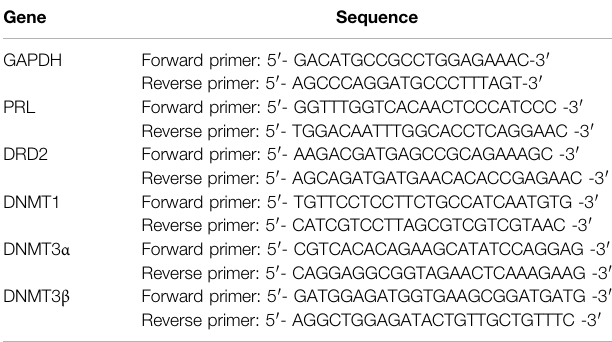
TABLE 2 | The sequences of the real-time PCR primers. Gene Sequence